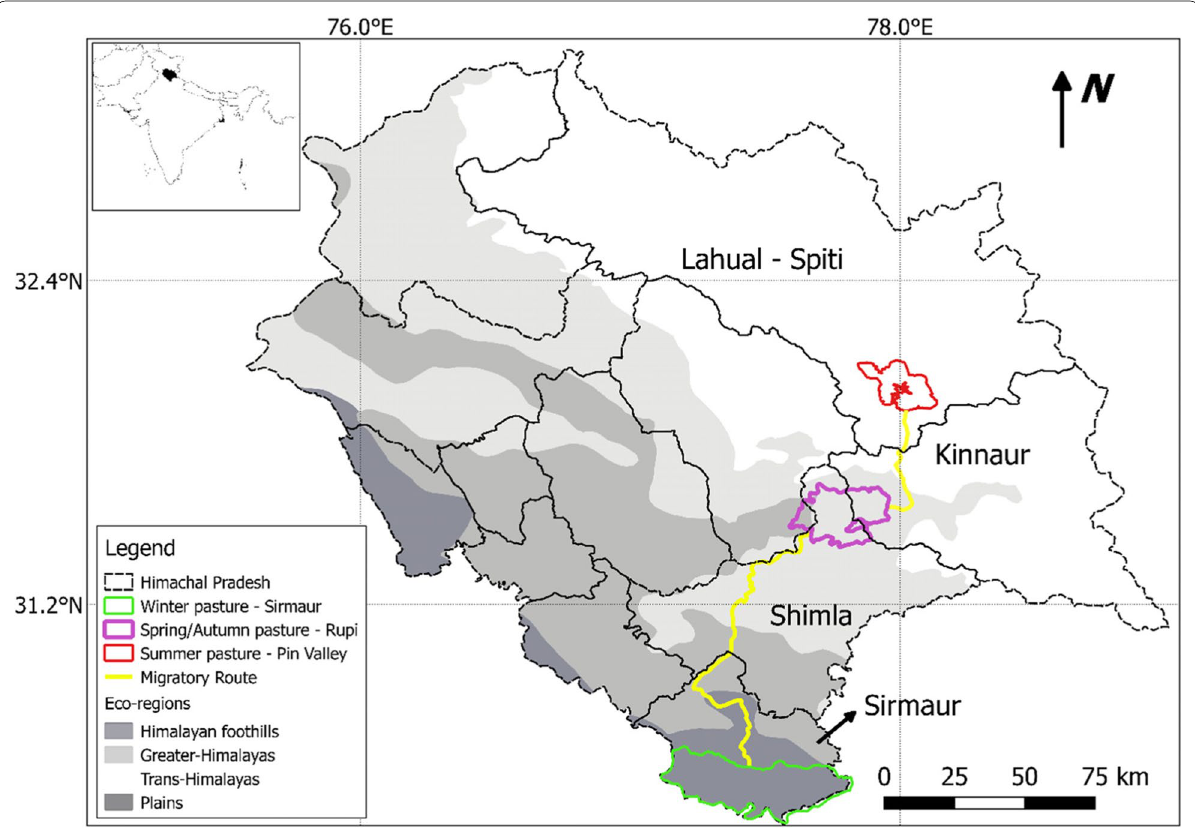
Fig. 1 Map displaying the migratory route and seasonal pastures of the Kinnaura herders. The inset map situates the state of Himachal Pradesh within India. Districts in Himachal Pradesh within which seasonal pastures of the Kinnaura herders are found are named on the map. Eco‑regions were obtained from Olson et al. (2001). Our study area (Pin valley) is outlined in